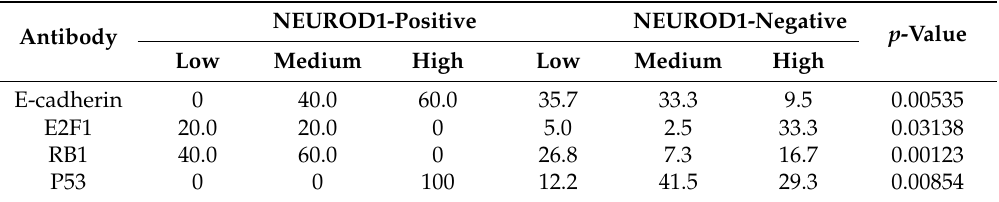
Table 6. Candidate target molecular expression in NEUROD1-positive and NEUROD1-negative samples. NEUROD1-Positive NEUROD1-Negative Antibody